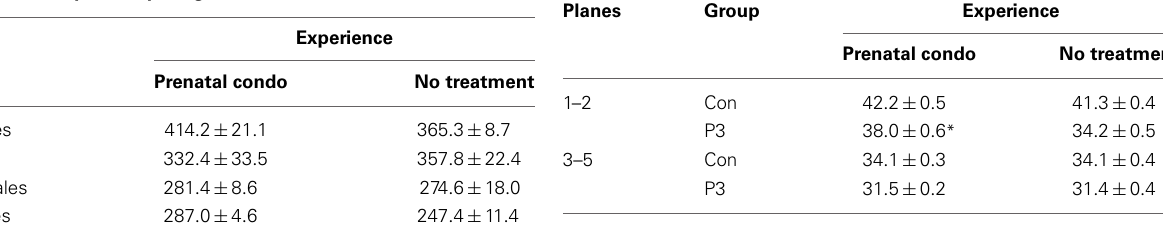
Table 1 | Summary of body weights.